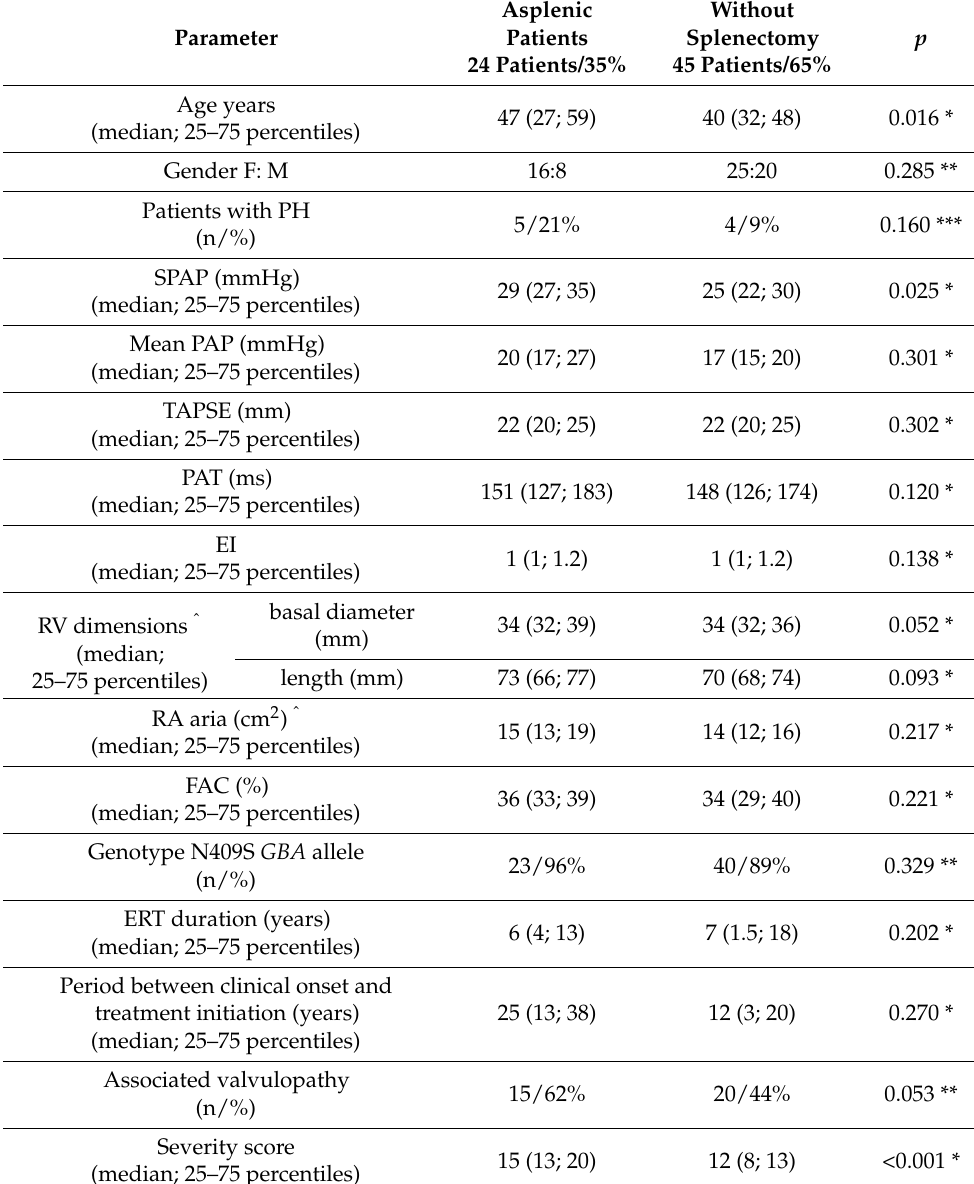
Table 5. Clinical and echocardiographic characteristics of asplenic patients compared with those without